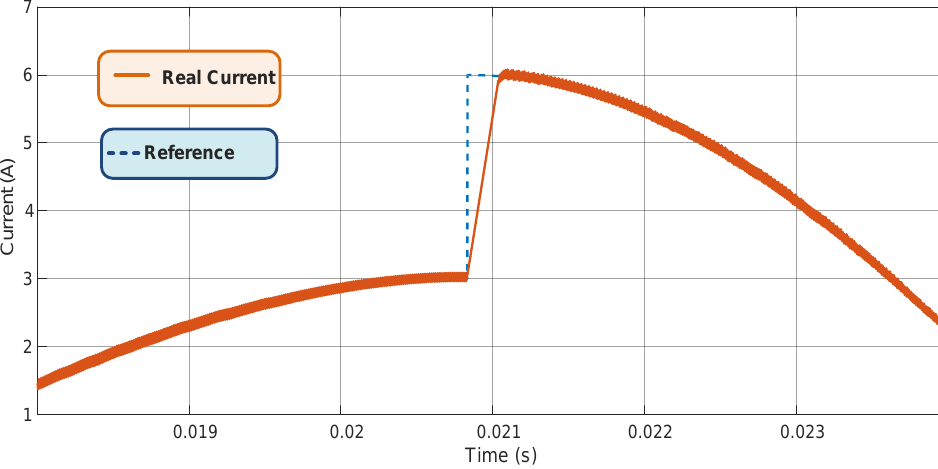
and i 1 —in detail. 1